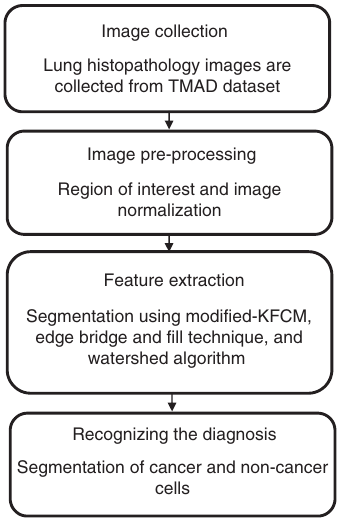
Figure 1: Workflow of the proposed